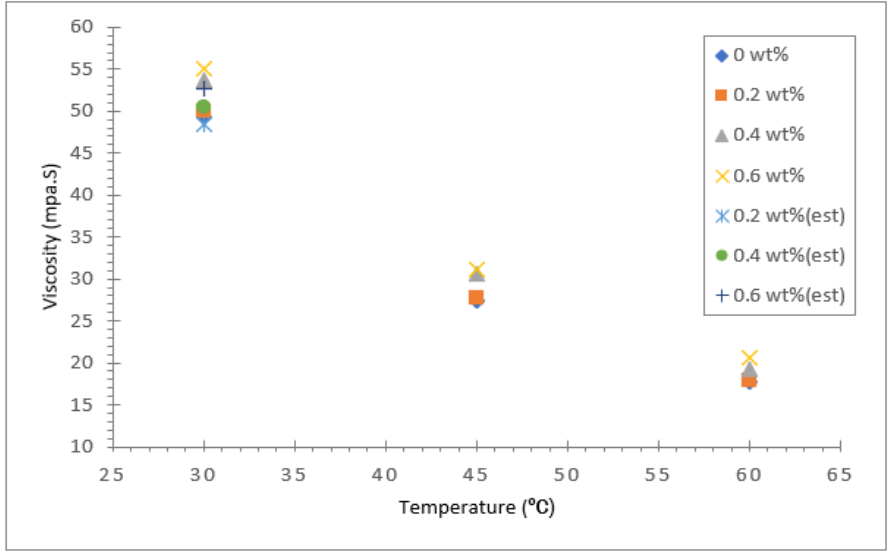
Figure 11. Dynamic viscosity of palm oil/Al 2 O 3 -TiO 2 hybrid nanofluid.